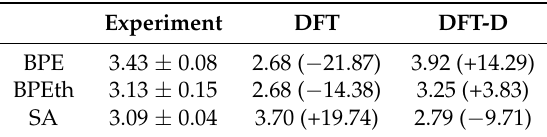
Table 2. Comparison of experimentally determined dielectric constant, (cid:101) , to the isotropically averaged values computed using DFT and DFT-D for the co-crystal components BPE, BPEth, and SA. Percent deviation from experiment is shown in parenthesis for DFT and DFT-D.